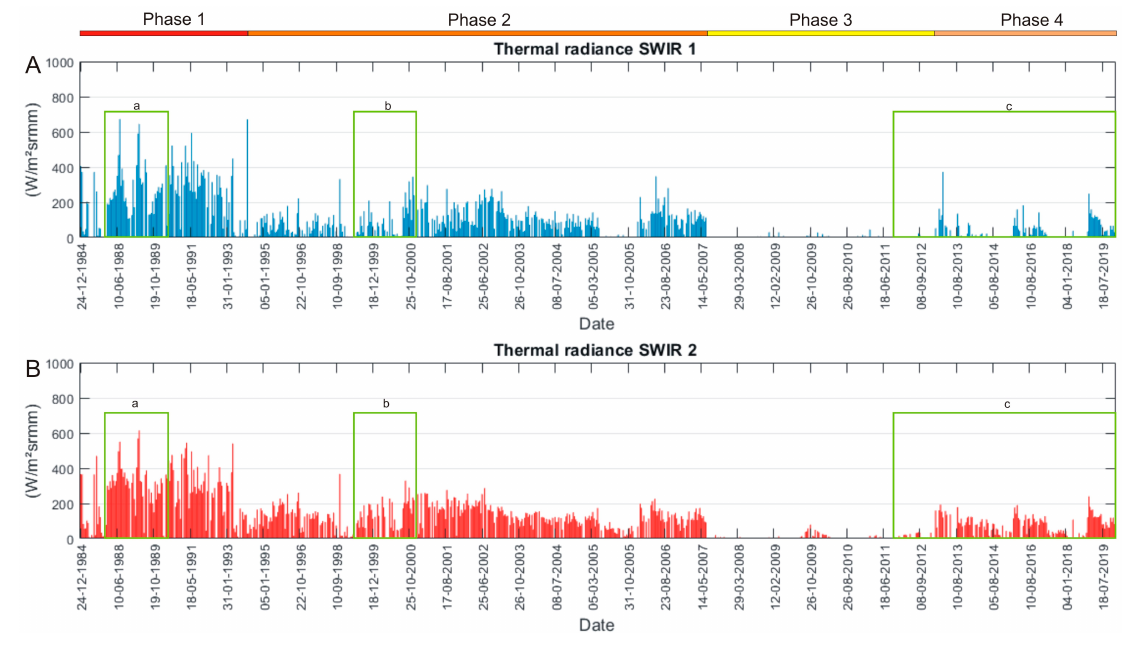
Figure 8. Lascar Volcano. Thermal radiance vs. date graphics, showing the four phases defined by the correlation between thermal radiance and volcanic activity. The a, b, and c squares indicate the periods considered in Figures 9 and 10. ( A ) Thermal radiance of SWIR1 band. ( B ) Thermal radiance of SWIR2 band.